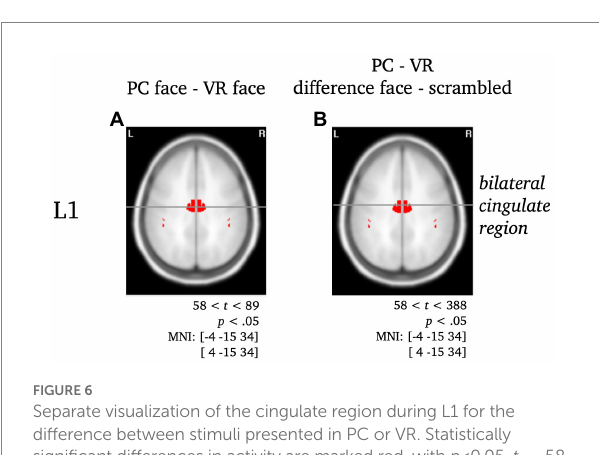
FIGURE 6 Separate visualization of the cingulate region during L1 for the difference between stimuli presented in PC or VR. Statistically significant differences in activity are marked red, with p < 0.05, t crit = 58. The center of gravity (CG) is labeled and the respective MNI coordinates are given.